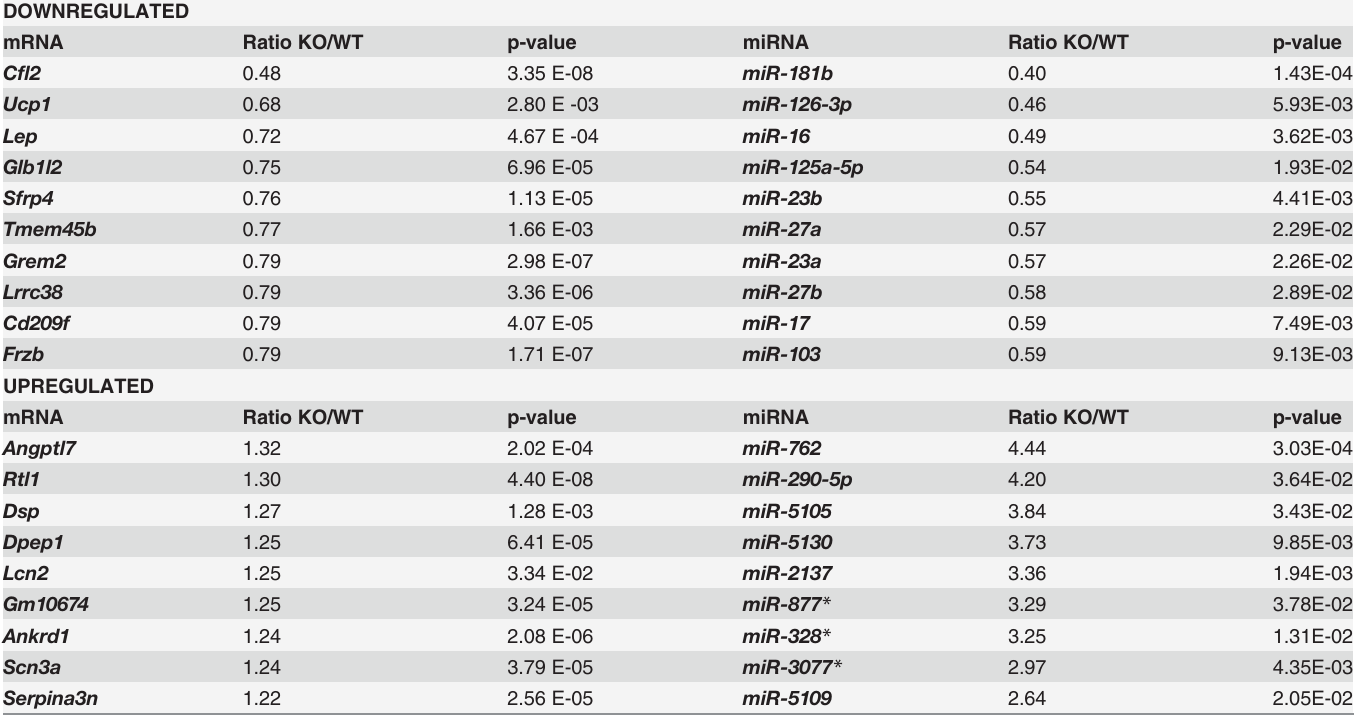
Table 1. The top ten mRNA and miRNAs with largest change in expression. DOWNREGULATED